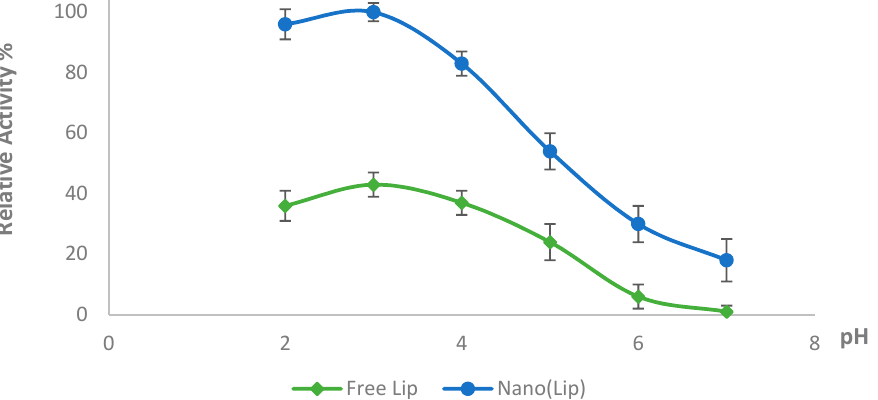
Figure 4. pH effect on the activity of free and Nano-LiP.